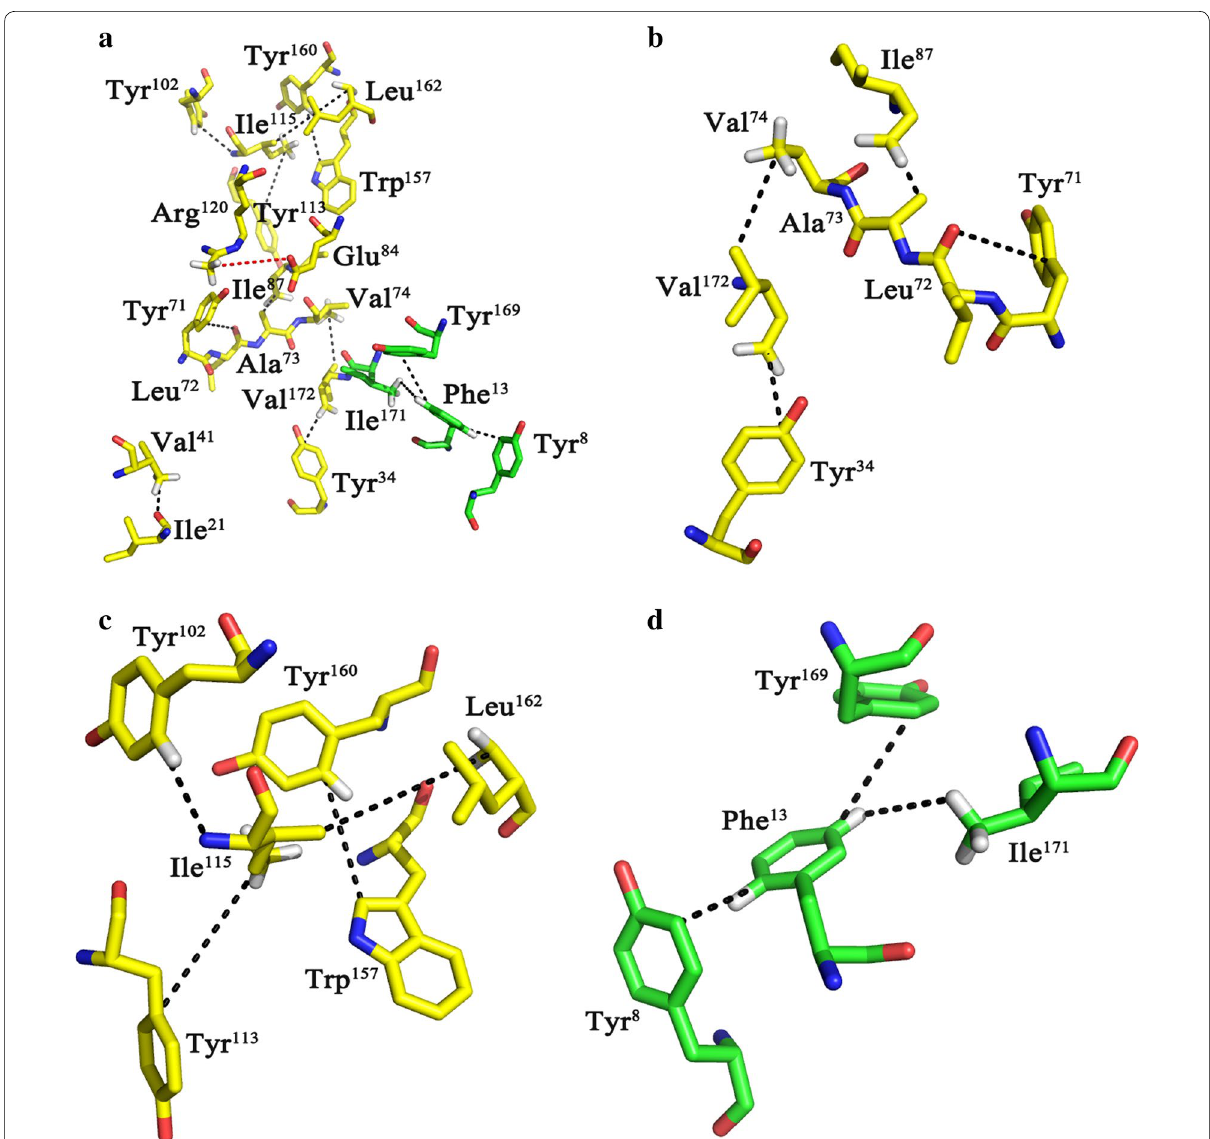
Fig. 7 Analysis of the intramolecular interactions in AoXyn11A G21I–Y13F . a Nine extra hydrophobic interactions (Ile 21 ‑Val 41 , Tyr 34 ‑Val 172 , Tyr 71 ‑Leu 72 , Ala 73 ‑Ile 87 , Val 74 ‑Val 172 , Tyr 102 ‑Ile 115 , Tyr 113 ‑Ile 115 , Ile 115 ‑Leu 162 and Trp 157 ‑Tyr 160 ) and one additional salt bridge (Glu 84 ‑Arg 120 ) were generated by substi‑ tuting Gly 21 with Ile. Three extra hydrophobic interactions (Phe 13 ‑Tyr 8 , Phe 13 ‑Tyr 169 and Phe 13 ‑Ile 171 ) were formed by mutation of Tyr13Phe. b , c Two large hydrophobic regions (Tyr 34 ‑Tyr 71 ‑Leu 72 ‑Ala 73 ‑Val 74 ‑Ile 87 ‑Val 172 and Tyr 102 ‑Tyr 113 ‑Ile 115 ‑Trp 157 ‑Tyr 160 ‑Leu 162 ) were illustrated in the locally magni‑ fied 3‑D structures. d Three hydrophobic interactions (Phe 13 ‑Tyr 8 , Phe 13 ‑Tyr 169 and Phe 13 ‑Ile 171 ) were illustrated in the locally magnified 3‑D